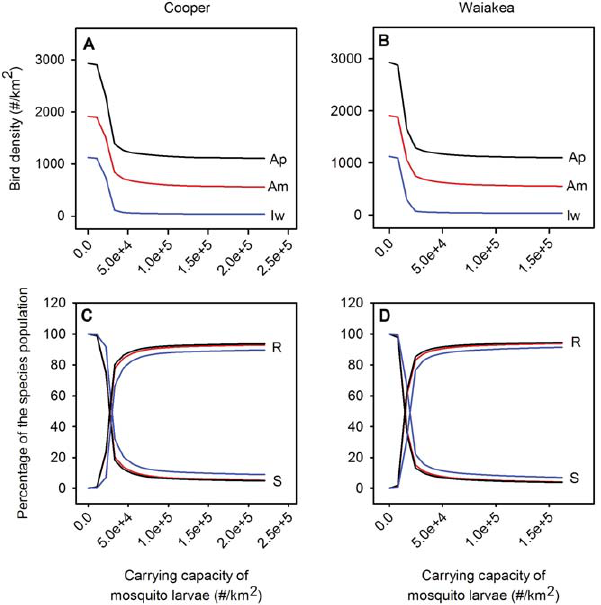
Figure 4. The mean annual densities of three Hawaiian honeycreepers and the mean annual percentages of their populations in the susceptible (S) and recovered (R or chronically-infected) stages as a function of larval carrying capacity for mid-elevation sites Cooper and Waiakea. Am=A- makihi (red line), Ap=Apapane (black line), and Iw=Iiwi (blue line).